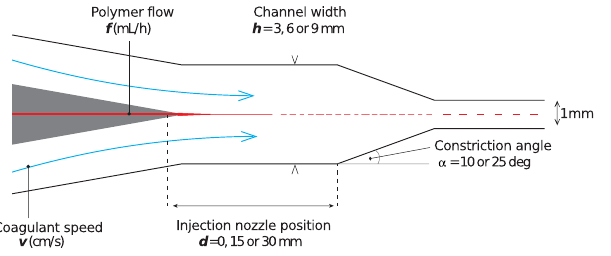
Figure 1. Diagram of short polymer fiber (SPF) synthesis using a microfluidic device and a polymer solution with higher viscosity than the coagulant. A primary breakup occurs as the polymer filament is elongated by the flowing coagulant during its gelation. A secondary breakup of the fibers can be induced by shear forces at the constriction of the laminar